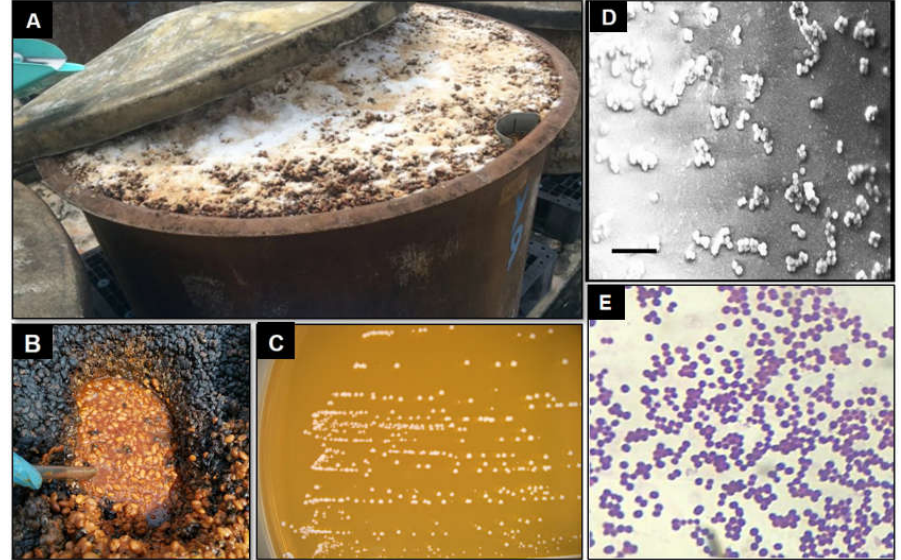
Figure 1. ( a ) Soy sauce moromi fermentation tank at a commercial soy sauce plant in Perak, Malaysia and ( b ) the 80 days sample of soy sauce moromi where bacterial strains were isolated. ( c ) THSK colonies on MRS agar supplemented with 5% NaCl after 3 days of incubation at 30°C; ( d ) THSK at 1000× magnification using Scanning Electron Microscope (Bar = 10 μm); ( e ) Positive Gram-stained THSK under 400× magnification.